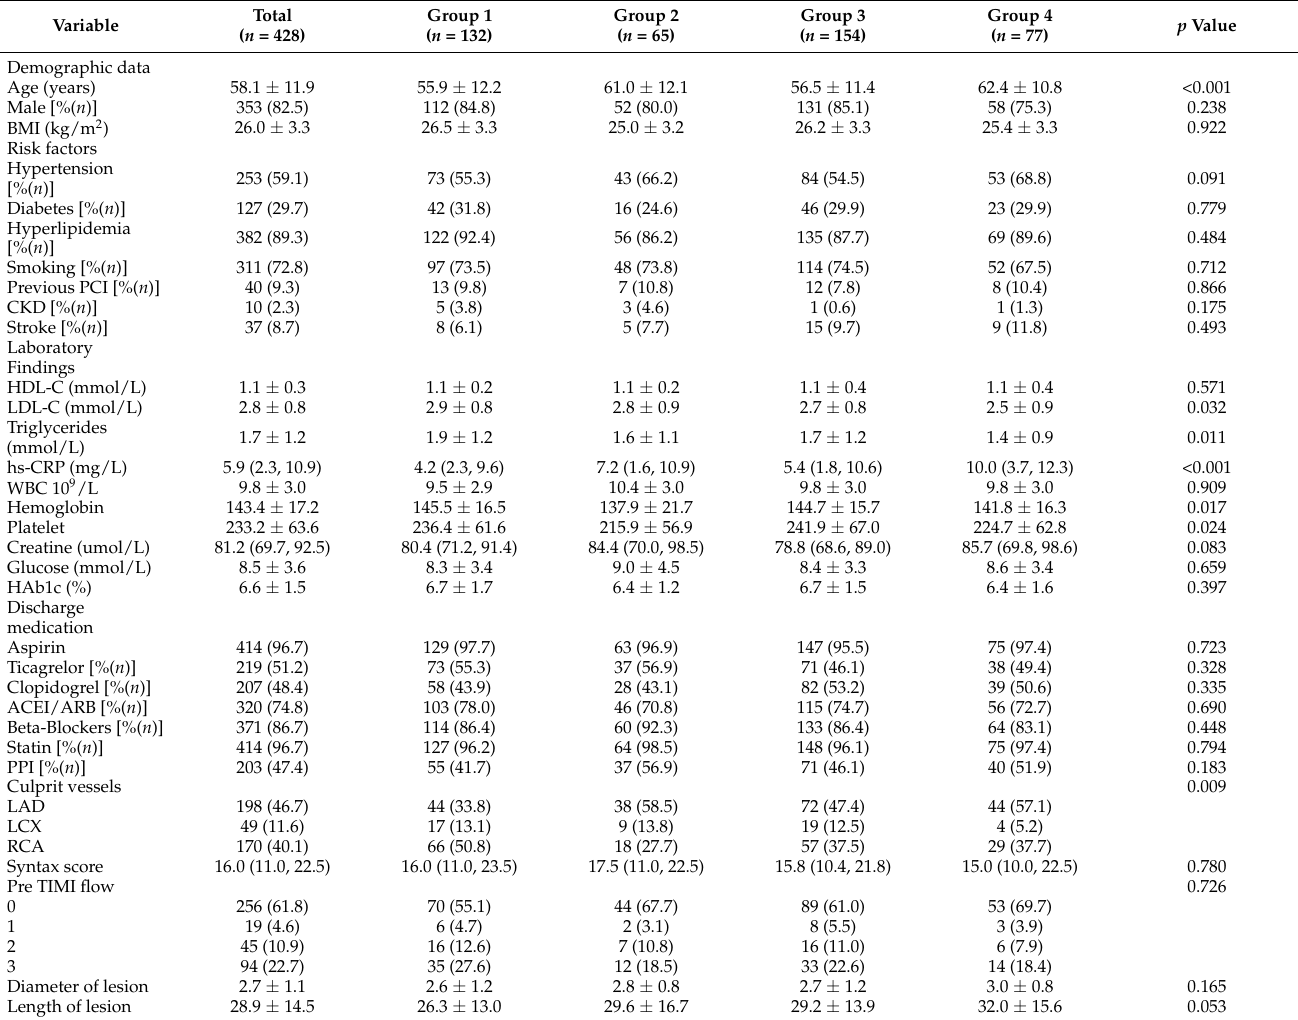
Table 1. Baseline clinical characteristics of the study